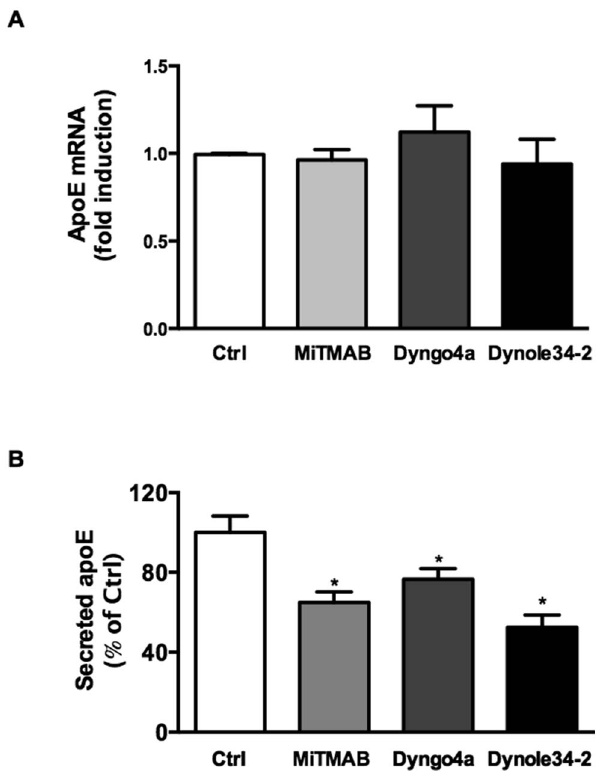
Figure 3. Dynamin inhibition affects apoE post translationally. HMDM were incubated with 30 m M MiTMAB, Dyngo-4a or Dynole-34-2 for 2 h and cellular apoE mRNA levels (A) were determined by real time PCR. CHO-apoE cells (B) were incubated with 30 m M MiTMAB, Dyngo-4a, or Dynole-34-2 for 2 h and secreted apoE levels were determined by ELISA. Data shown in (A) are mean 6 SD from triplicate cultures representative of at least 2 individual donors for HMDM while panel B are mean 6 SEM from 3